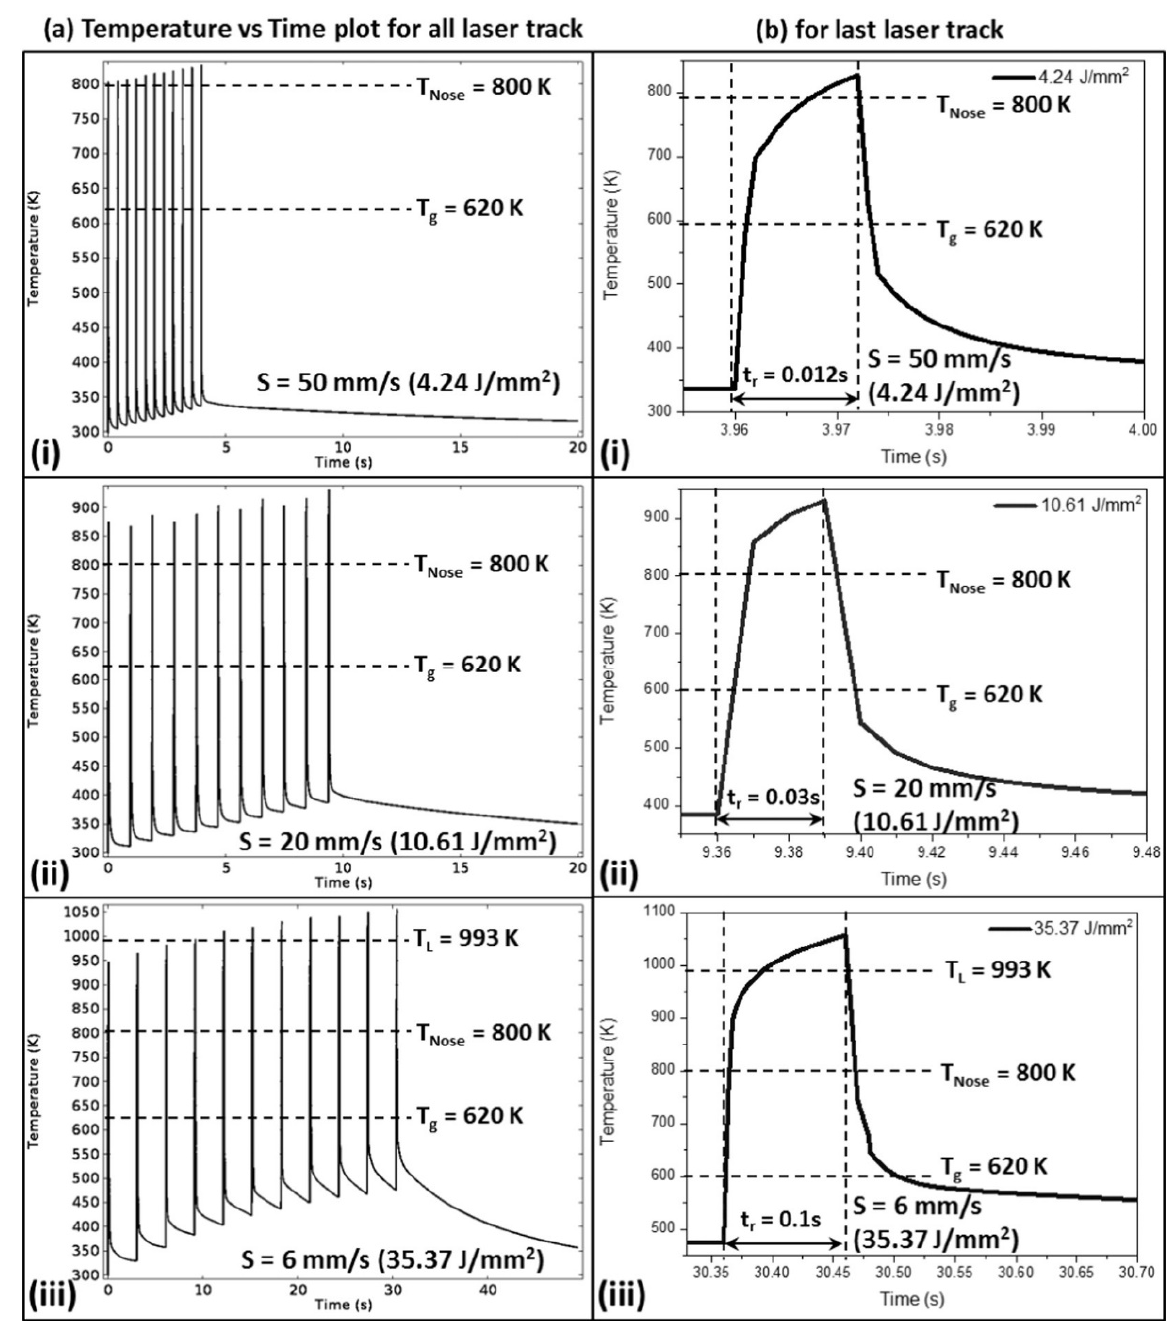
Figure 40. Simulated thermal histories with three scanning speeds ( a ) for all 11 laser tracks and ( b ) the last track. Reproduced from [94], with permission from Elsevier, 2021.